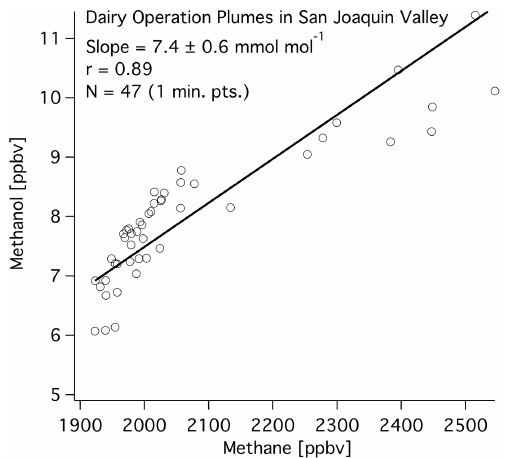
Figure 6. Methanol and methane concentrations are well cor- related in dairy operation plumes sampled via aircraft (flight dates: 5/7, 6/14, 2010). Ratios of methanol to methane average 7.4 ± 0.6mmolmol − 1 and range up to 16molmol − 1 due to the het- erogeneity in emission pathways at dairy operations. Note: the data shown here represent a subset of dairies in the